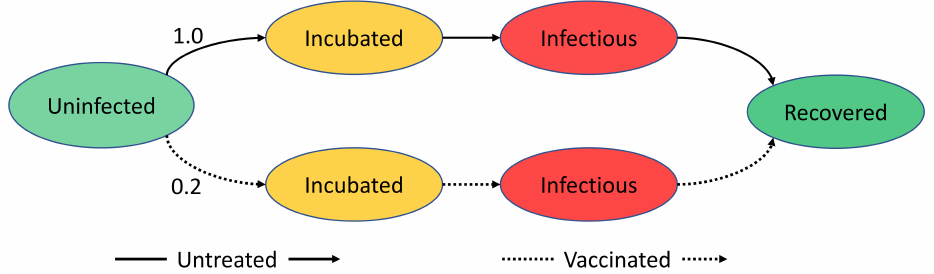
Figure 2. A simple disease model that shows the progression of disease within an agent. Ovals represent disease states, while the lines represent the transition between states. The labels on lines show the probabilities of